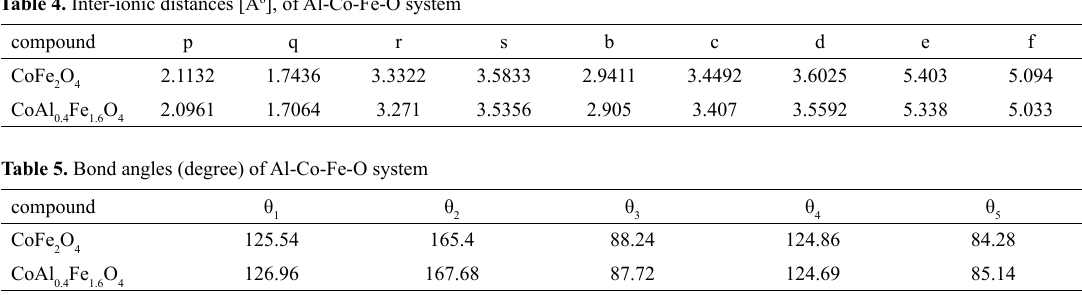
Table 6. Elastic constants for Al-Co-Fe-O system